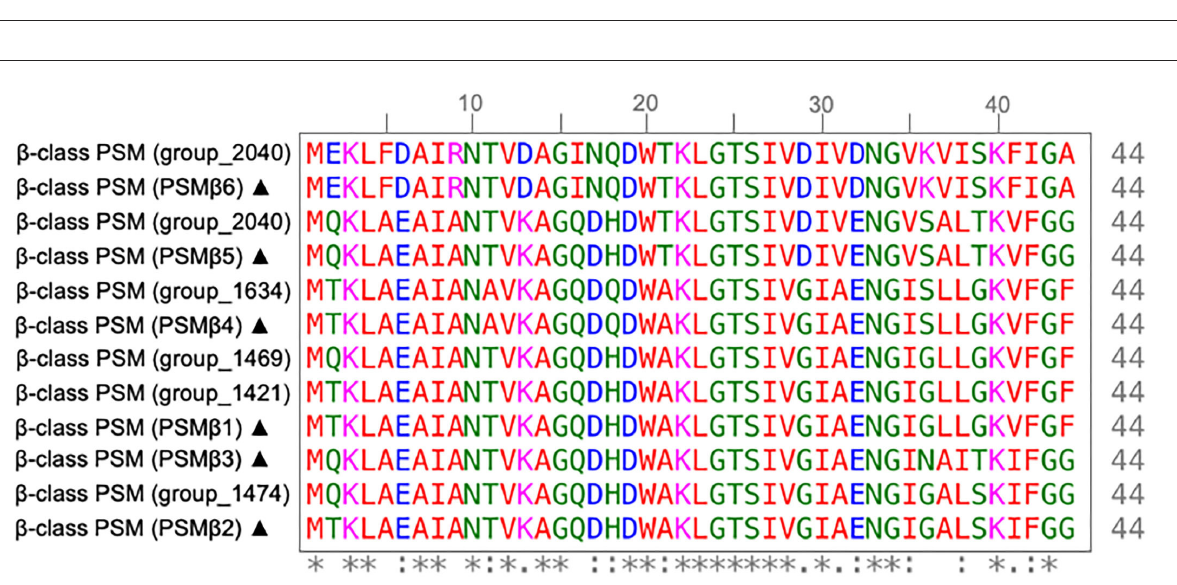
FIGURE4 Multiple sequence alignment of β -class phenol soluble modulins (PSMs) of S. capitis isolates. MSA of β -class PSMs protein sequences found in S. capitis genomes from this study and those described by O’Neill (2020) (sequences marked with N ) created with ClustalW (Clustal et al., 1994). Residues are colored based on an amino acid property (red: small and hydrophobic, blue: acidic, magenta: basic, green: hydroxyl, sulfhydryl, and amine, and gray: unusual), positions that contain fully conserved residues are marked with an asterisk, and positions marked with a colon indicate conservation between groups of amino acids with similar